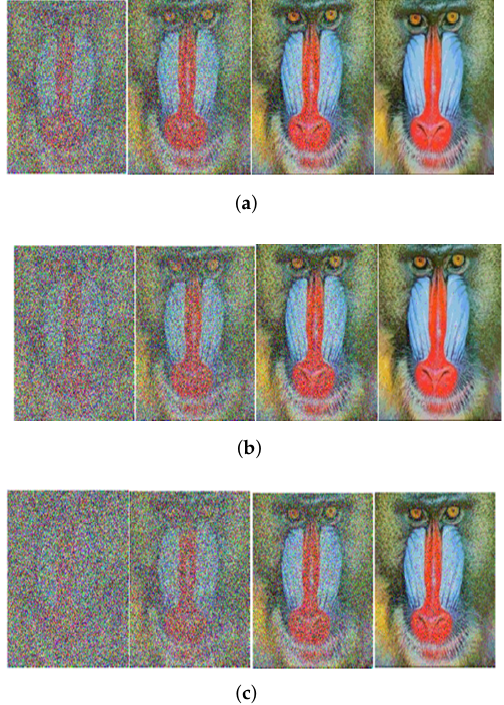
Figure 20. Received image with massive MIMO incorporated DWT-OFDM over a Rayleigh channel, Modulated with 32-PSK and at SNR = 0, 10, 20, 30 dB from Left to Right for different number of users, n . ( a ) n = 10; ( b ) n = 20; ( c ) n = 50.